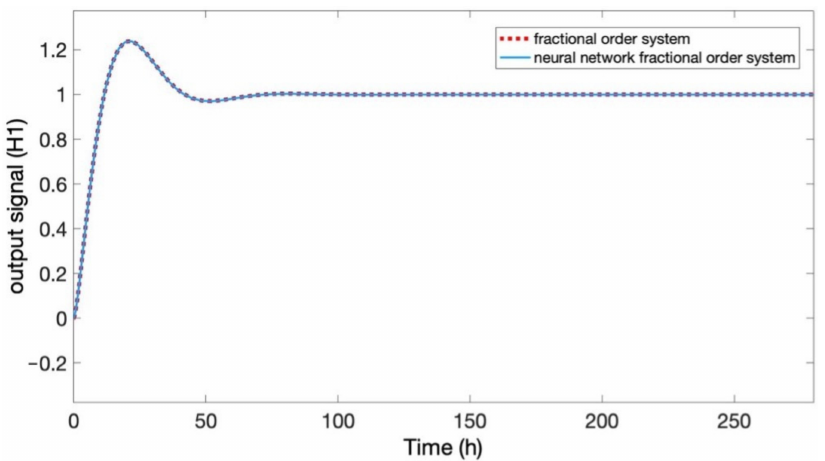
Figure 10. The comparison between the response of the Oustaloup approximation implemented using the first two neural networks and the response of the fractional-order system ( β = 1.45 >